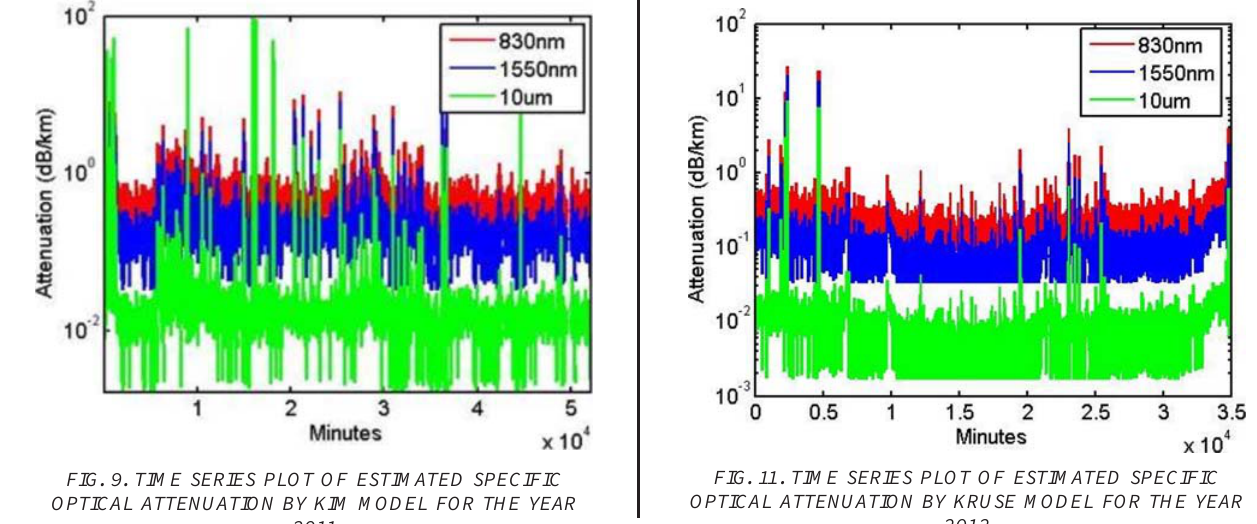
FIG. 9. TIME SERIES PLOT OF ESTIMATED SPECIFIC OPTICAL ATTENUATION BY KIM MODEL FOR THE YEAR